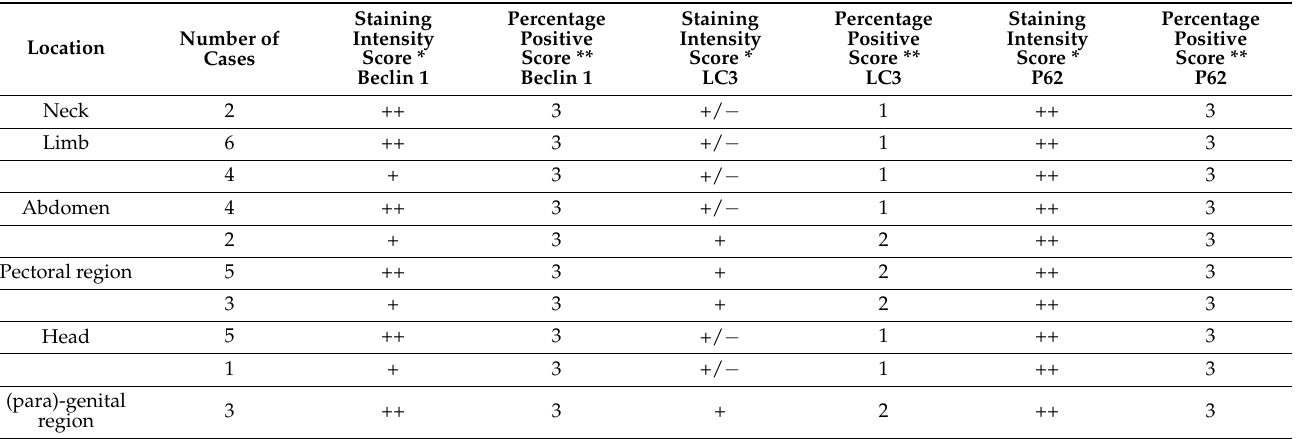
Table 1. Staining intensity and percentage positive scores for Beclin 1, LC3 and P62 in 35 BPV positive equine